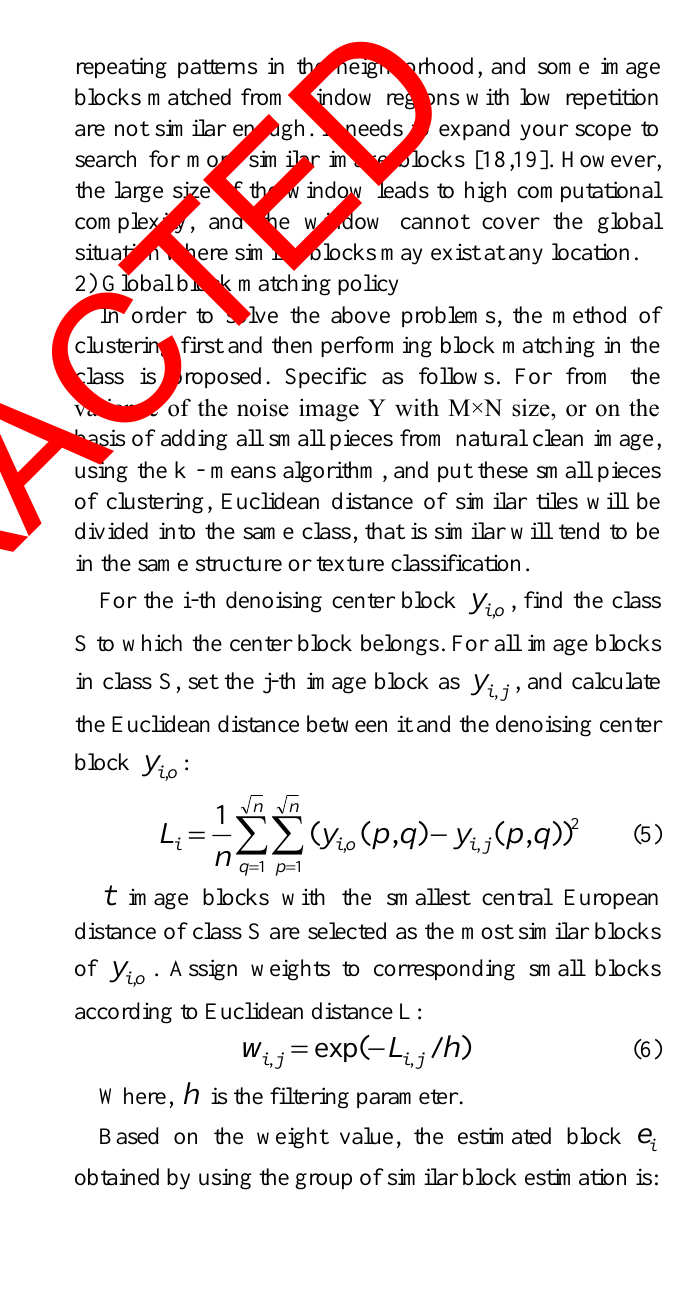
Figure 1. Single iteration flow chart of NCSR